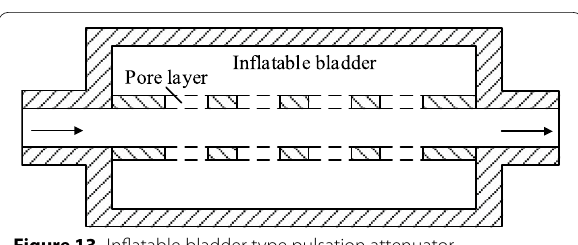
Figure 12 Thin plate vibration type pulsation attenuators: a Single thin plate, b multiple thin plates